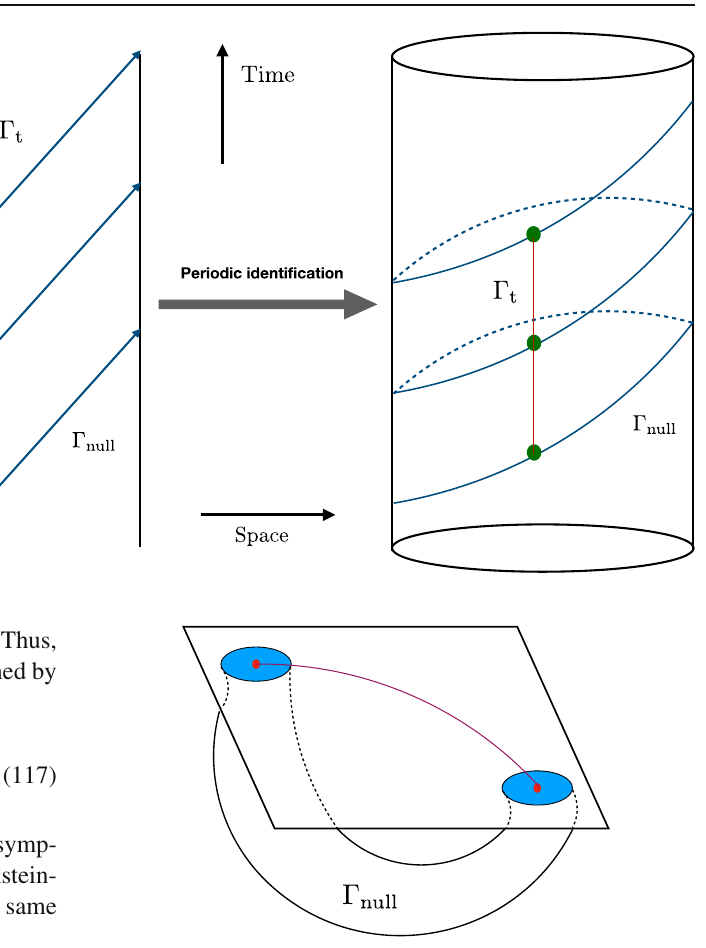
Fig. 18 A schematic diagram demonstrating an ANEC-violating but SCAANEC-preserving traversable Wormhole configuration. The red points are connected by the Wormholes, as well as by boundary time- like paths and the latter is shorter than the